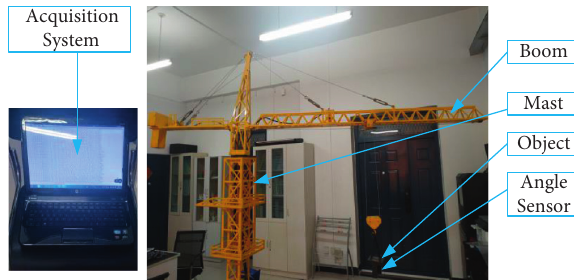
Figure 4: Components of the test bench.